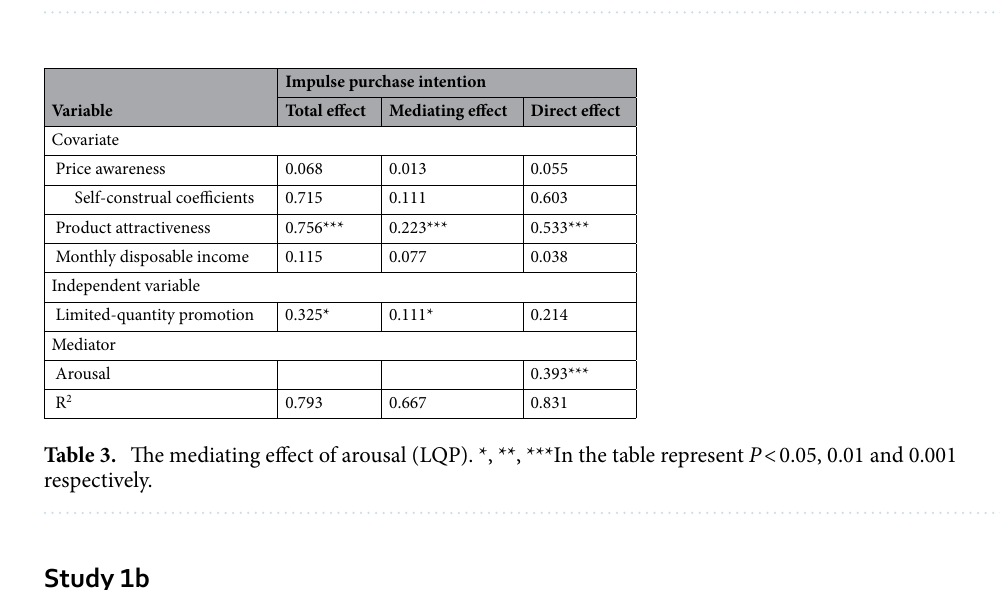
Table 2. the mediating effect of arousal (LTP). *, **, ***In the table represent P < 0.05, 0.01 and 0.001 respectively.